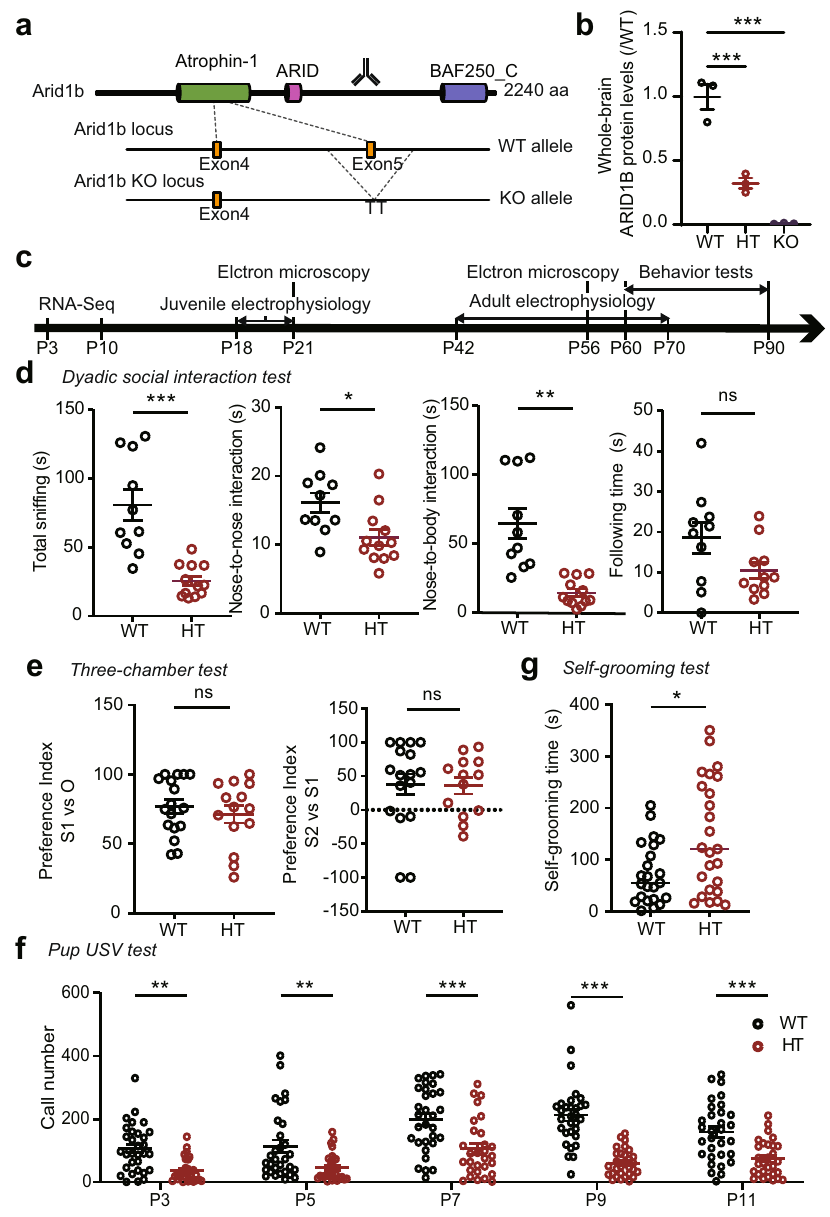
Fig. 1 | Autistic-like social and repetitive behavioral de fi cits in Arid1b +/ – mice. a Strategy for Arid1b knockout (KO) in mice. A protein-truncating mutation was introduced by inserting “ TT ” nucleotides at the starting region of exon 5, which encodes partofthe atrophin-1 domain. The antibody-targeting region isindicated. Atrophin-1, ARID, and BAF250_C indicate speci fi c domains of the Arid1b protein. b Reduced levels of ARID1B protein in Arid1b +/ – (HT) and Arid1b – / – (KO) mice, respectively, at P0. ( n =3 mice [WT, HT, and KO], ordinary one-way ANOVA with Dunnett ’ stest,[WTvsHT: p =0.0005,WTvsKO: p <0.0001]). c Postnatalstagesat which RNA-Seq, electrophysiological, electron microscopic, and behavioral experimentswereperformedinanalysesof Arid1b +/ – mice. d Decreaseddirectsocial interaction of Arid1b +/ – mice (2 – 3 months) in the dyadic social-interaction test, as shownbytotaltimespentinsocialinteraction(nose-to-nosesnif fi ng,nose-to-body snif fi ng, and following). ( n =10 pairs of mice [WT], 12 [HT], two-tailed Student ’ s t-test [total snif fi ng: p <0.0001, nose-to-nose: p =0.0117, following: p